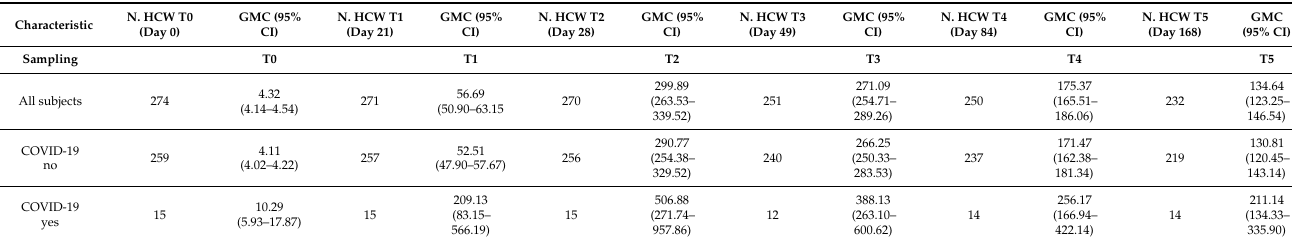
Table 2. GMC and 95% CI for all subjects, COVID-19 negative and COVID-19 positive at T0, T1, T2, T3 T4 and T5 (6 months after first